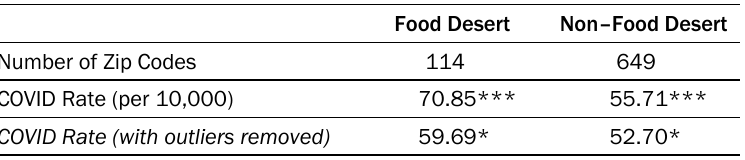
Table 1. Comparison of COVID-19 Effects on Food Deserts versus Non – Food